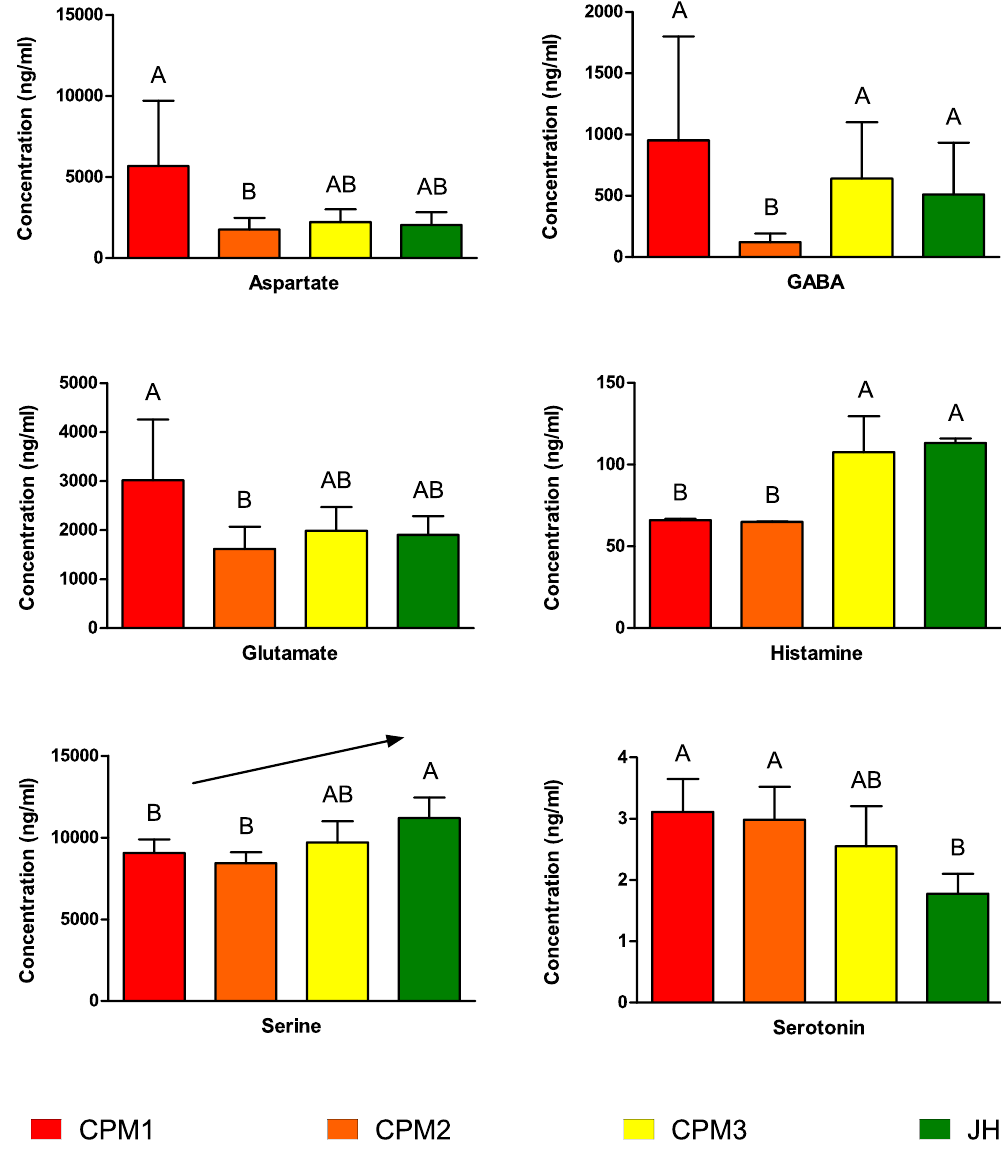
Figure 3. Mean plasma concentrations of neurotransmitters in caged goldfish from Cootes Paradise Marsh (CPM1, CPM2, and CPM3) and the reference site, Jordan Harbour (JH). A and B denote groups with significantly different means (ANOVA, n = 25, p < 0.05, Tukey’s Multiple Comparison, α = 0.05). Error Bars = 95% CI. Arrow indicates a significant linear